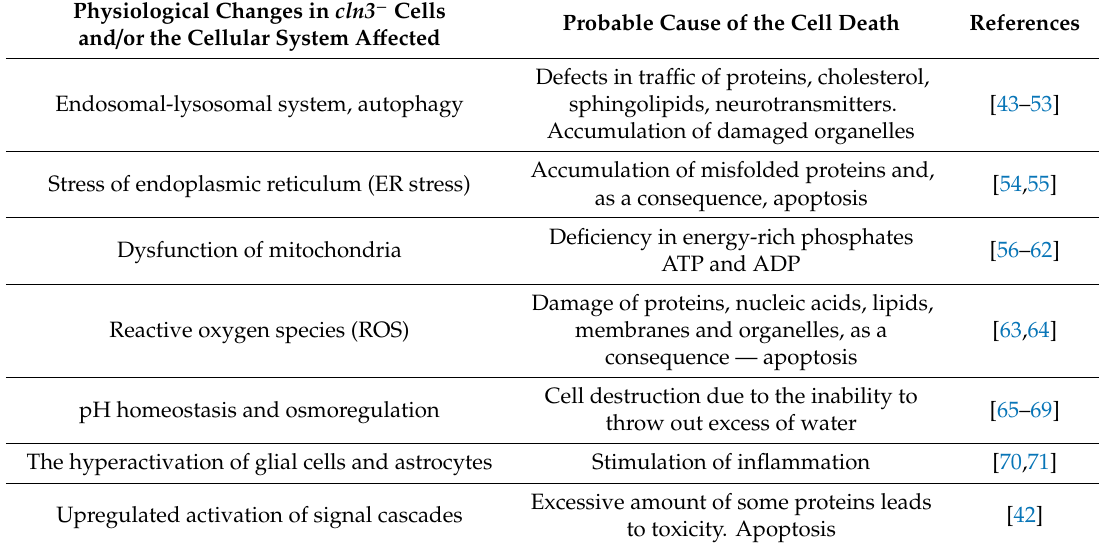
Table 1. Possible molecular mechanisms of the JNCL (juvenile neuronal ceroid lipofuscinosis). Physiological Changes in cln3 −